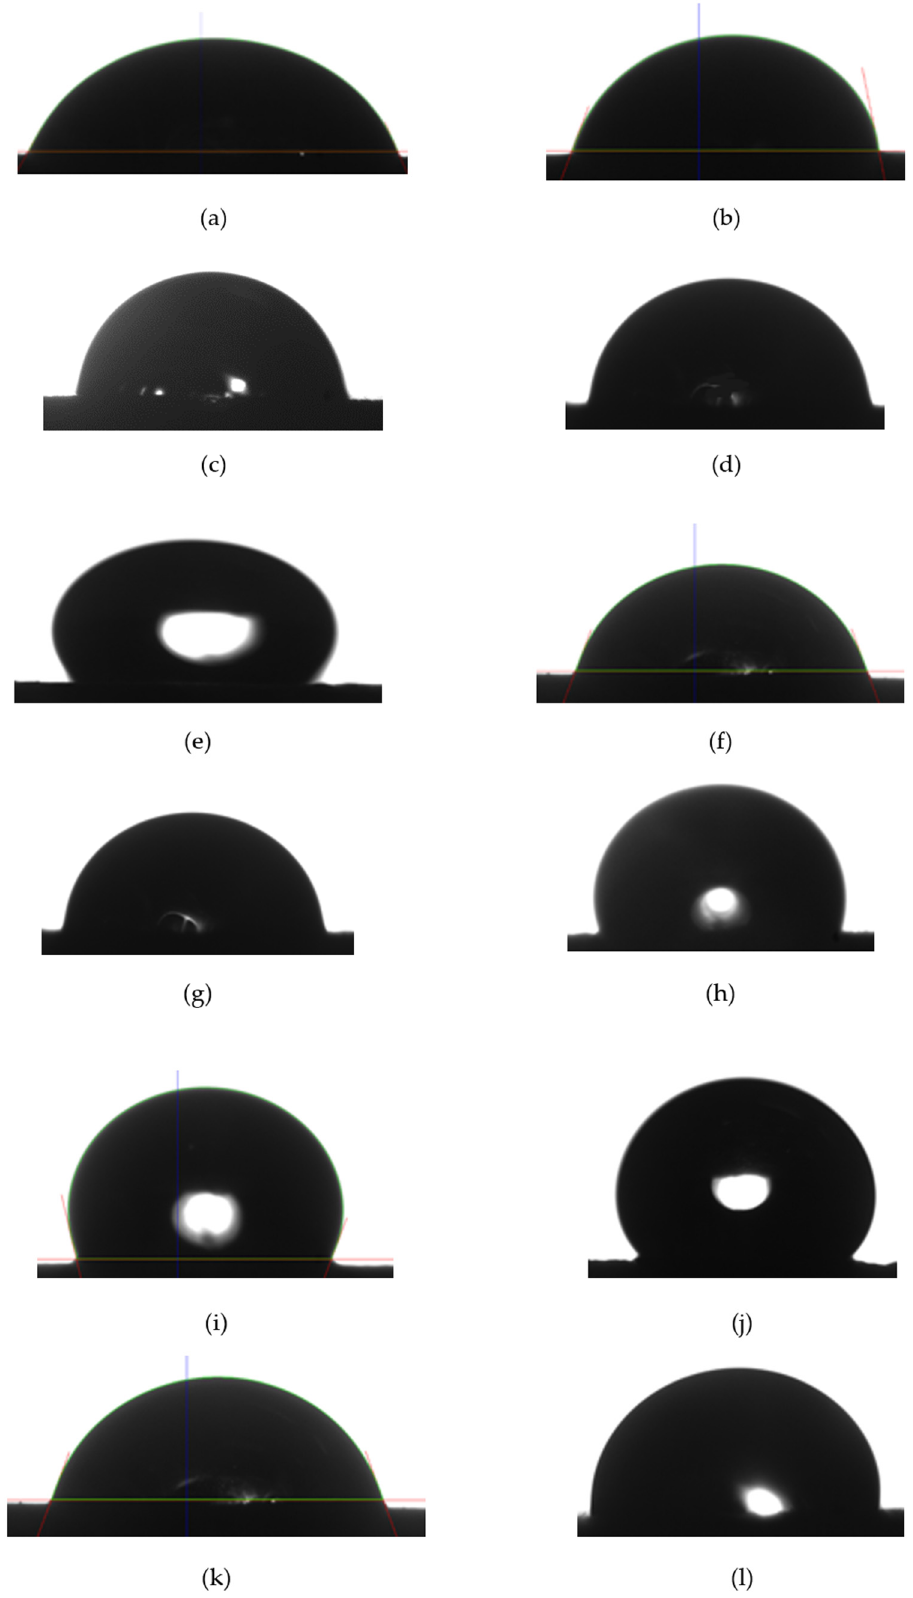
Figure 1. Brine droplet of size 5 × 10 − 4 mL placed onto the aged top end piece. ( a ) Chalk 1 ( θ = 65 ◦ ); ( b ) Chalk 2 ( θ = 66 ◦ ); ( c ) Chalk 3 ( θ = 78 ◦ ); ( d ) Chalk 4 ( θ = 85 ◦ ); ( e ) Chalk 5 ( θ = 102 ◦ ); ( f ) Berea 1 ( θ = 70 ◦ ); ( g ) Berea 2 ( θ = 82 ◦ ); ( h ) Berea 3 ( θ = 93 ◦ ); ( i ) Berea 4 ( θ = 102 ◦ ); ( j ) Berea 5 ( θ = 112 ◦ ); ( k ) Silurian dolomite 1 ( θ = 65 ◦ ); ( l ) Silurian dolomite 2 ( θ = 95 ◦